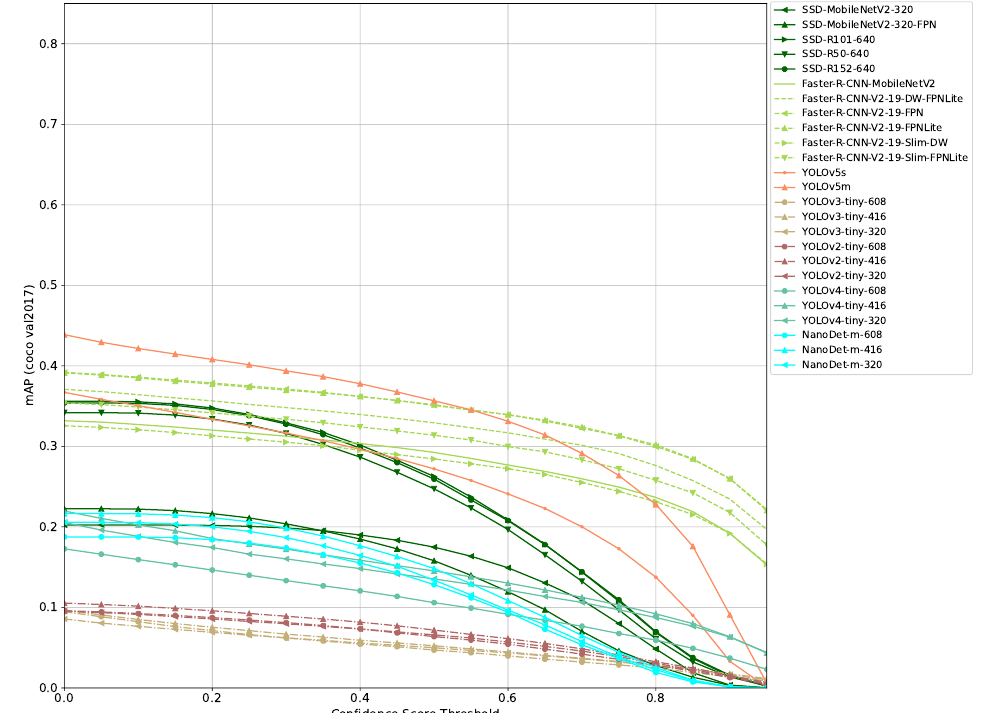
Figure 3. COCO mAP results of models selected (smaller models).